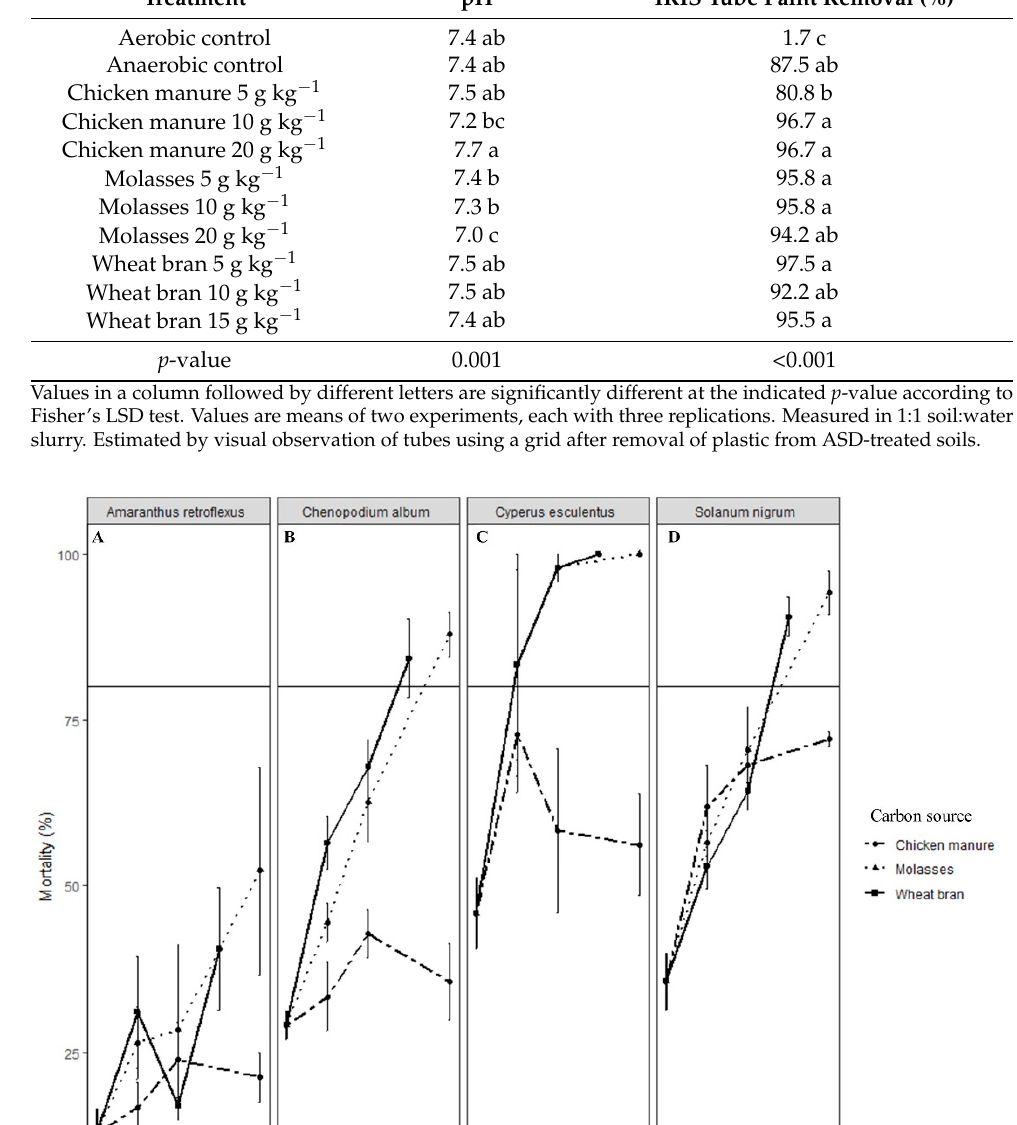
Table 5. Effects of anaerobic soil disinfestation (ASD) with different carbon sources rates on soil pH and iron oxide paint removal percent from Indicator of Reduction in Soils (IRIS) tubes under growth chamber conditions.